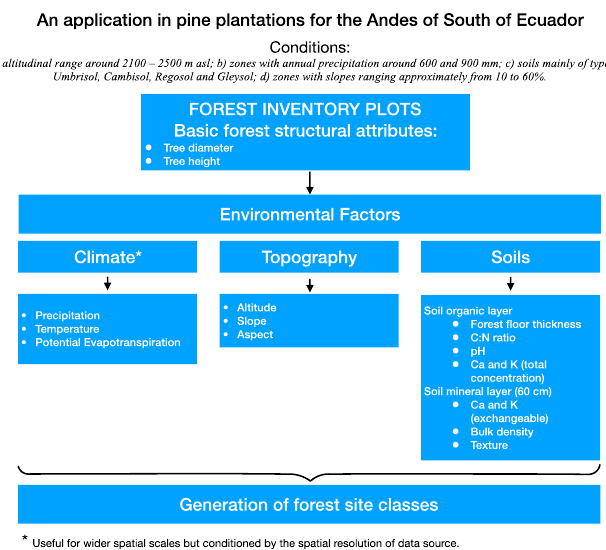
Figure 3. Synthesized protocol for forest site classification for pine plantations in the Andes of South of Ecuador.